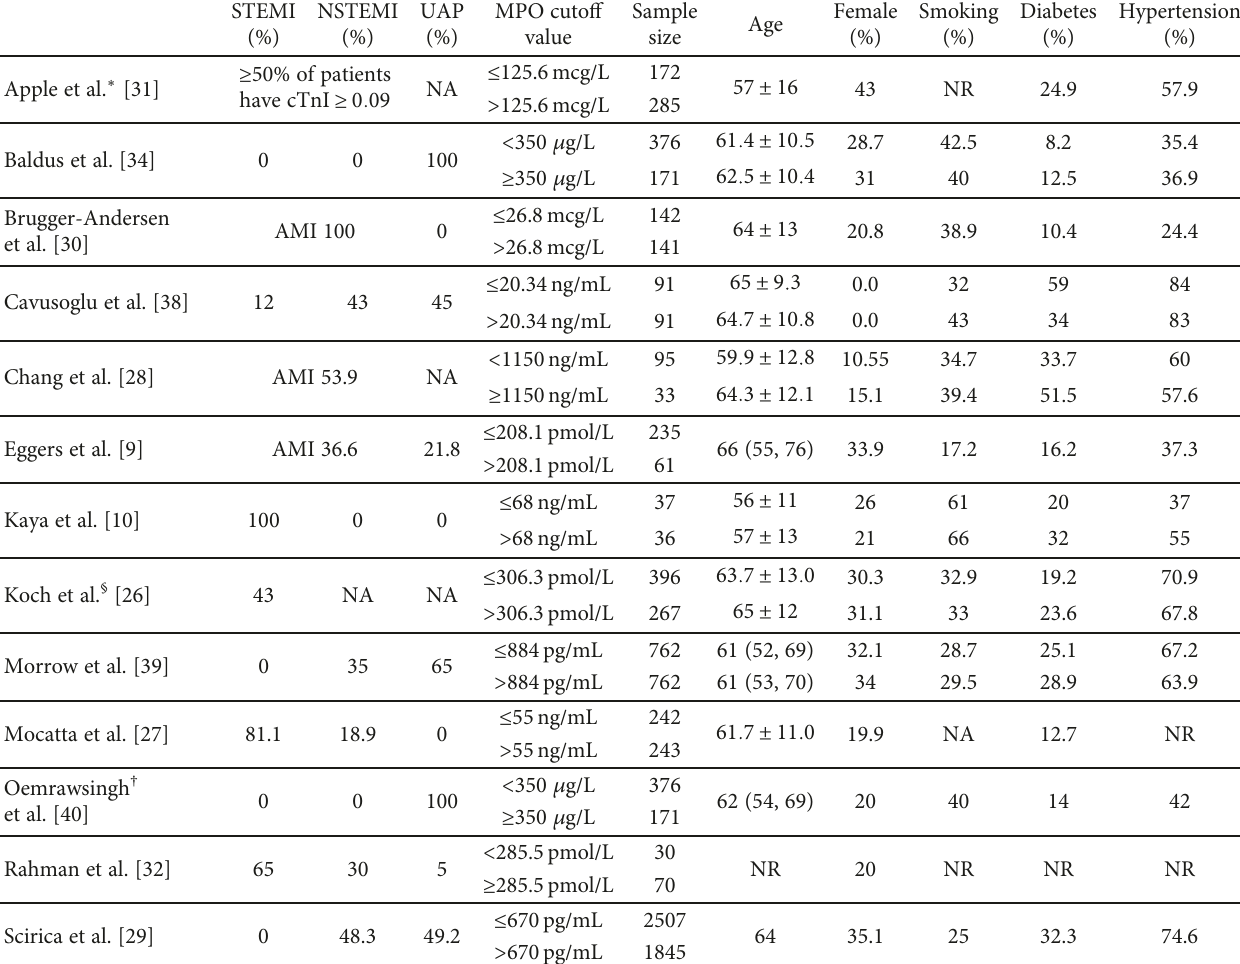
Table 1: Patients ’ characteristics of the studies included in the meta-analysis.